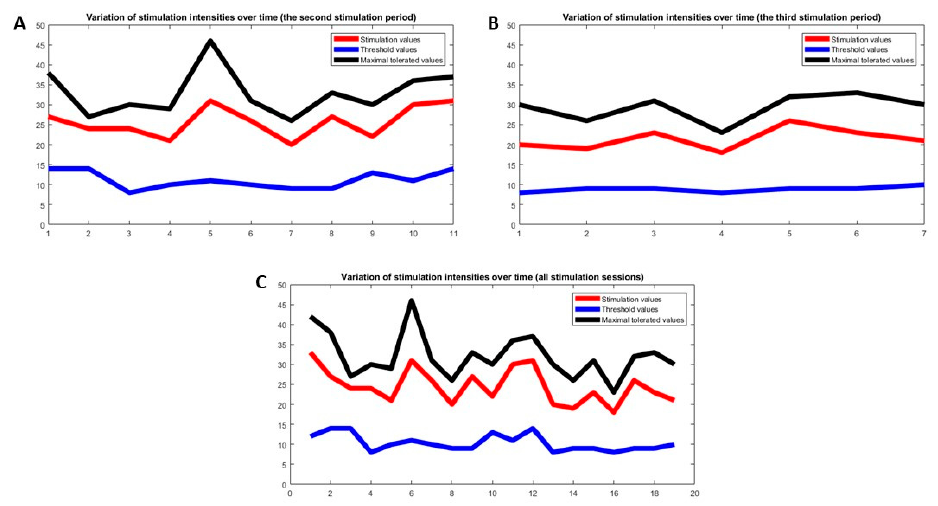
Figure 3. Stimulation intensities over time. ( A ) Second stimulation period with high stimulation intensities two months after the first stimulation period in the acute phase. ( B ) Third stimulation period with lower stimulation intensities three months after the first stimulation period. ( C ) Stimulation intensities of all three stimulation periods over time with decreasing stimulation intensities.